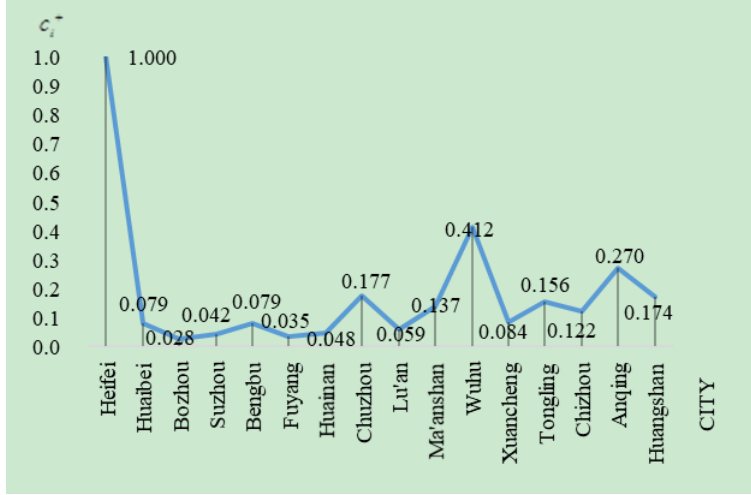
Figure 5. The comparison of social sustainability of cities in Anhui province.